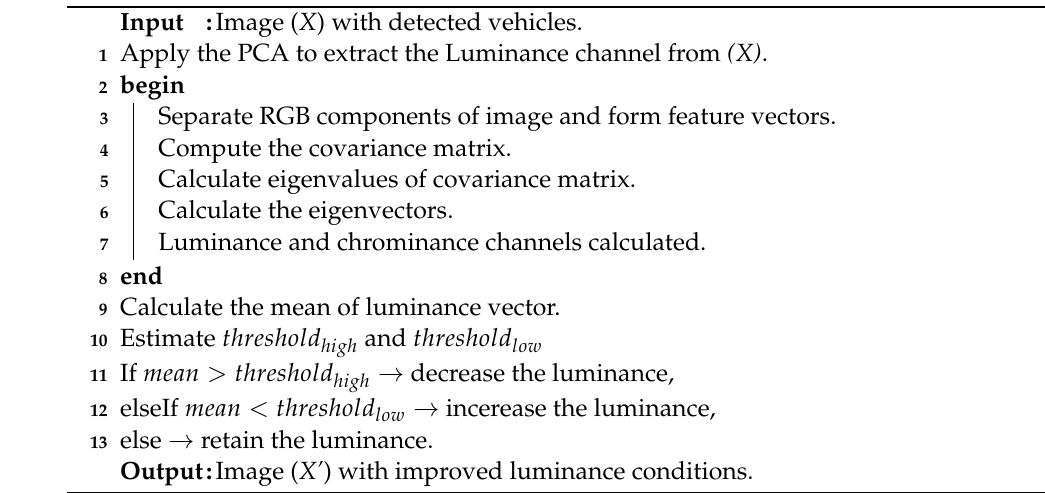
Algorithm 2: Pseudo code to handle the reflective glare